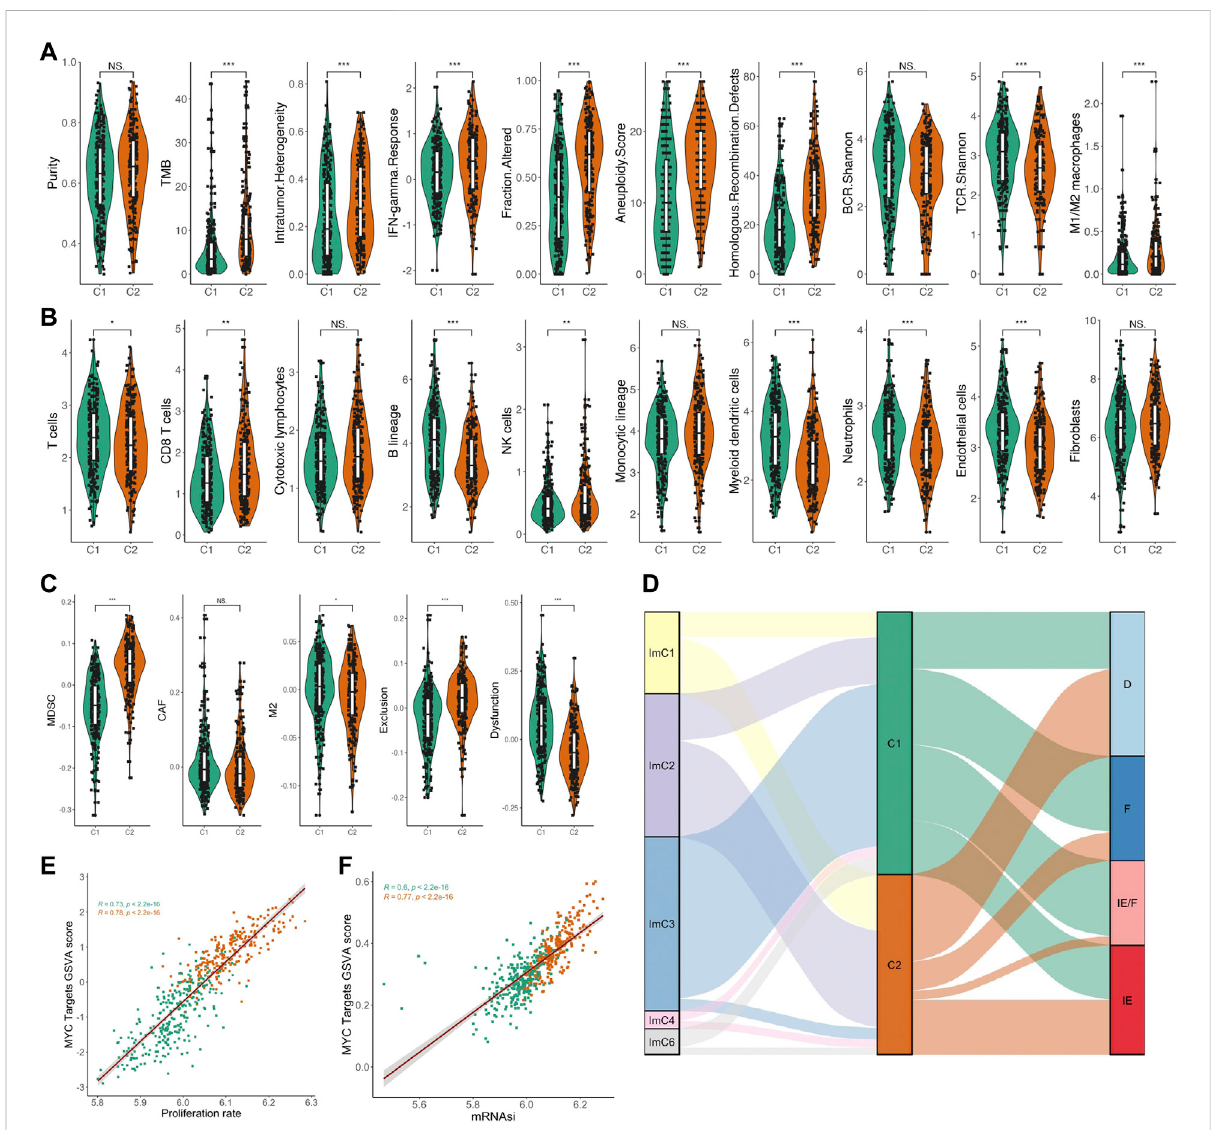
FIGURE 4 Relationship between MYC signaling and genomic instability score, immune microenvironment, cell proliferation, and tumor stemness. (A) Comparison of the purity, TMB, intratumor heterogeneity, IFN-gamma response, fraction altered, aneuploidy score, homologous recombination defects, BCR.Shannon, TCR.Shannon, M1/M2 macrophage between C1 and C2. (B) Comparison of the abundance of immune cell in fi ltration between C1and C2. (C) Comparison of thescores of TILfor MDSC, CAF, and M2,as wellas twoindicators related to immunotherapy response: T-cell dysfunction and exclusion between C1 and C2. (D) Association of C1/C2 with two immune microenvironment types. (E) Correlation of the MYC Target GSVA score and cell proliferation. (F) Correlation of the MYC Target GSVA score and tumor